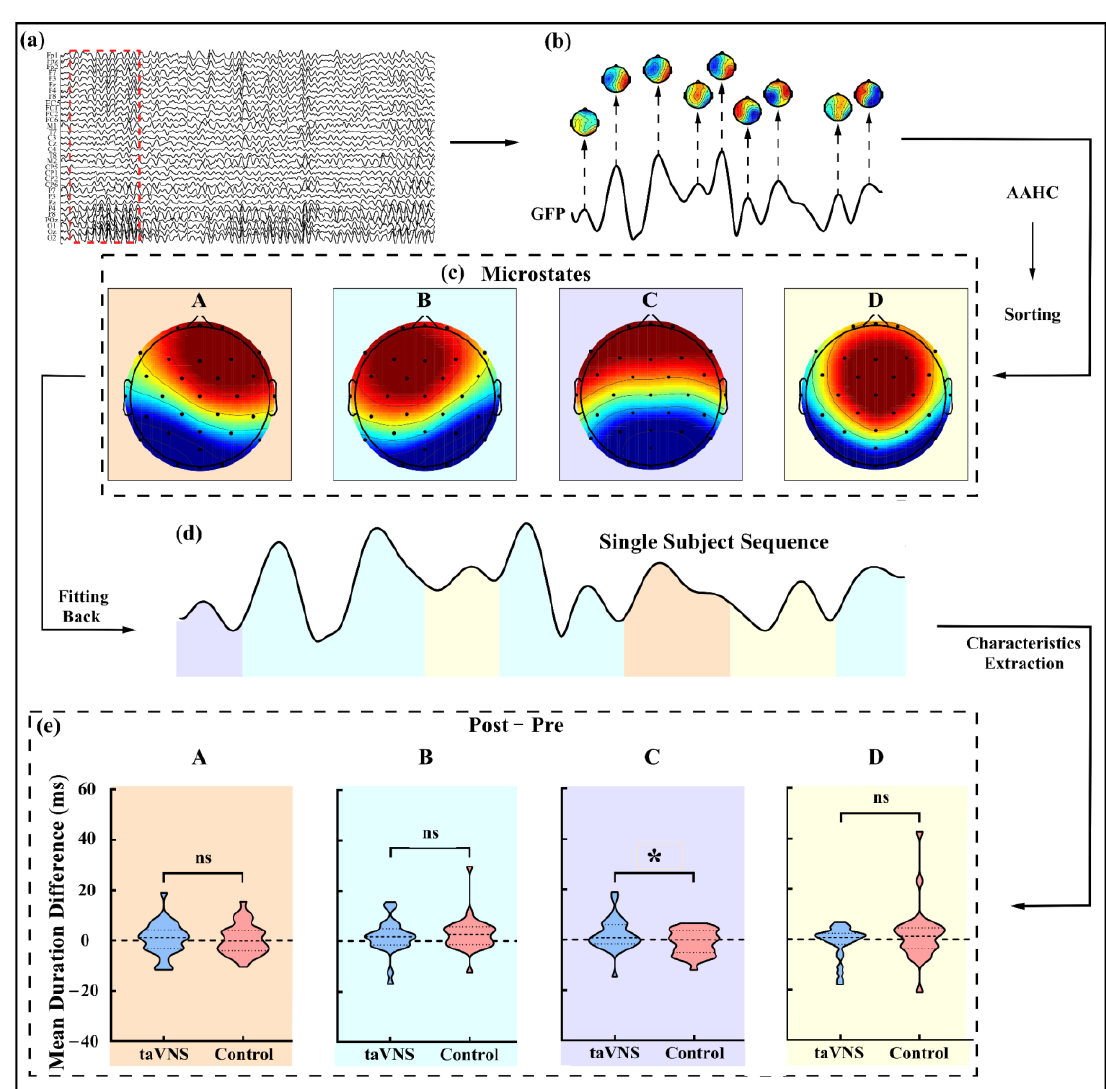
Figure 3. Microstate analysis procedure and mean duration difference of each microstate under the close-eye resting state. ( a ) EEG data after preprocessing; ( b ) GFP of signals marked by red dashed box in (a) and topographies at the latencies of GFP peaks; ( c ) Four microstates (i.e., microstates A–D) obtained by integrating all subjects’ EEG data after AAHC and sorting; ( d ) Single subject sequence obtained by back fitting from global microstate templates; ( e ) Mean duration difference for each microstate (i.e., microstates A – D, respectively, marked in different colors) under the close-eye resting state was extracted and calculated by single subject sequence. GFP, global field power; AAHC, atomize and agglomerate hierarchical clustering. * p < 0.05.